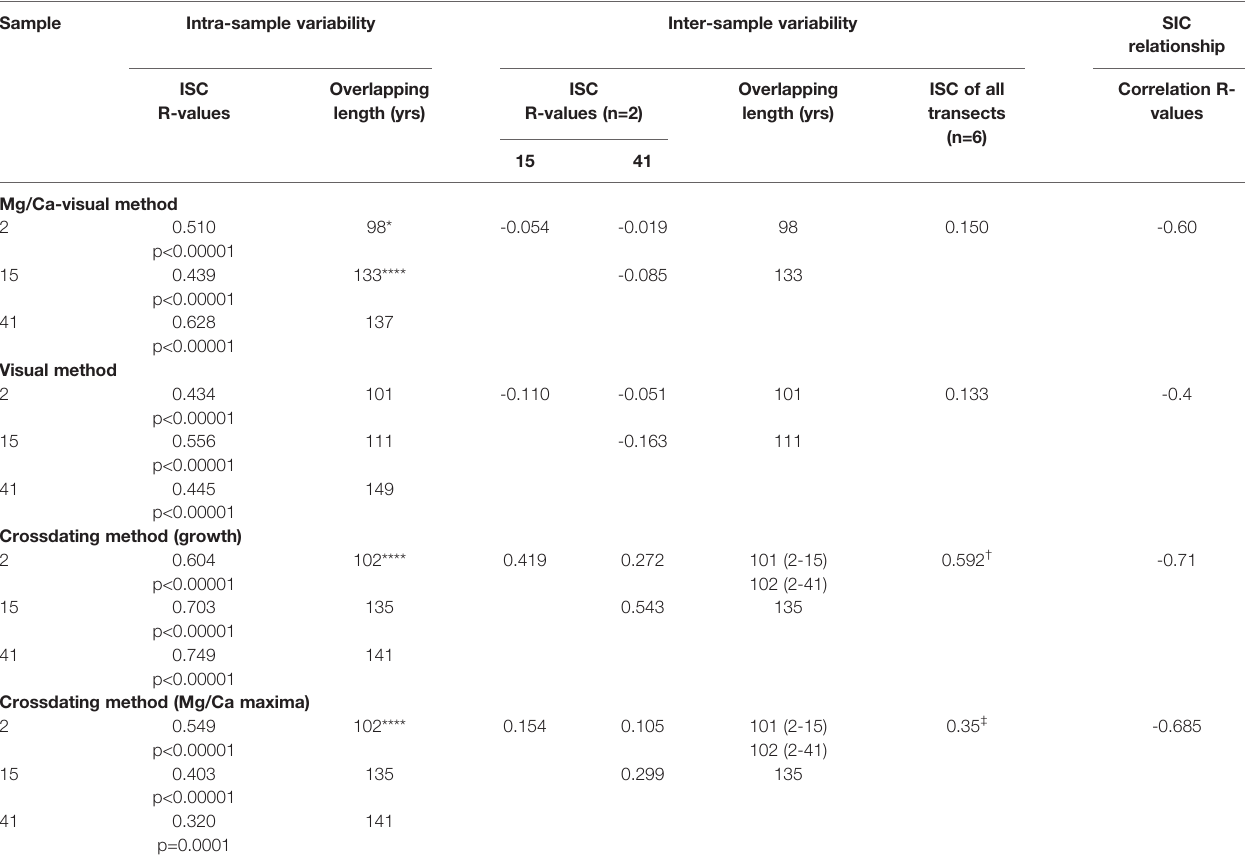
TABLE 2 | Comparison of intra- and inter-sample COFECHA calculated inter-series correlation (i.e., ISC: 50-year windows) of annual growth increment widths.